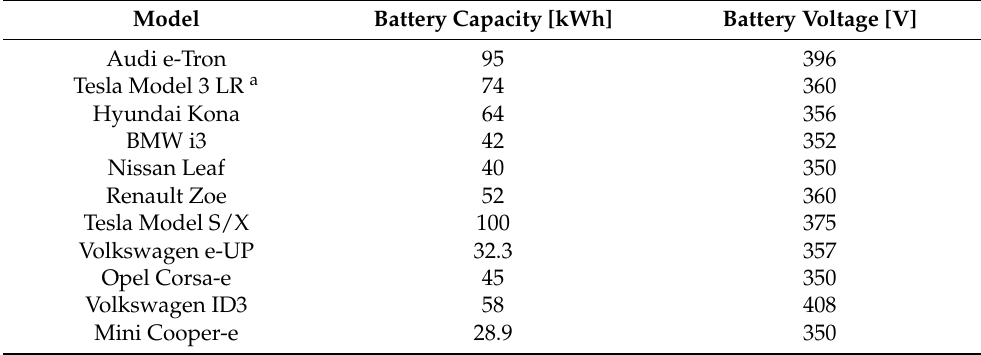
Table 1. Considered EV models.